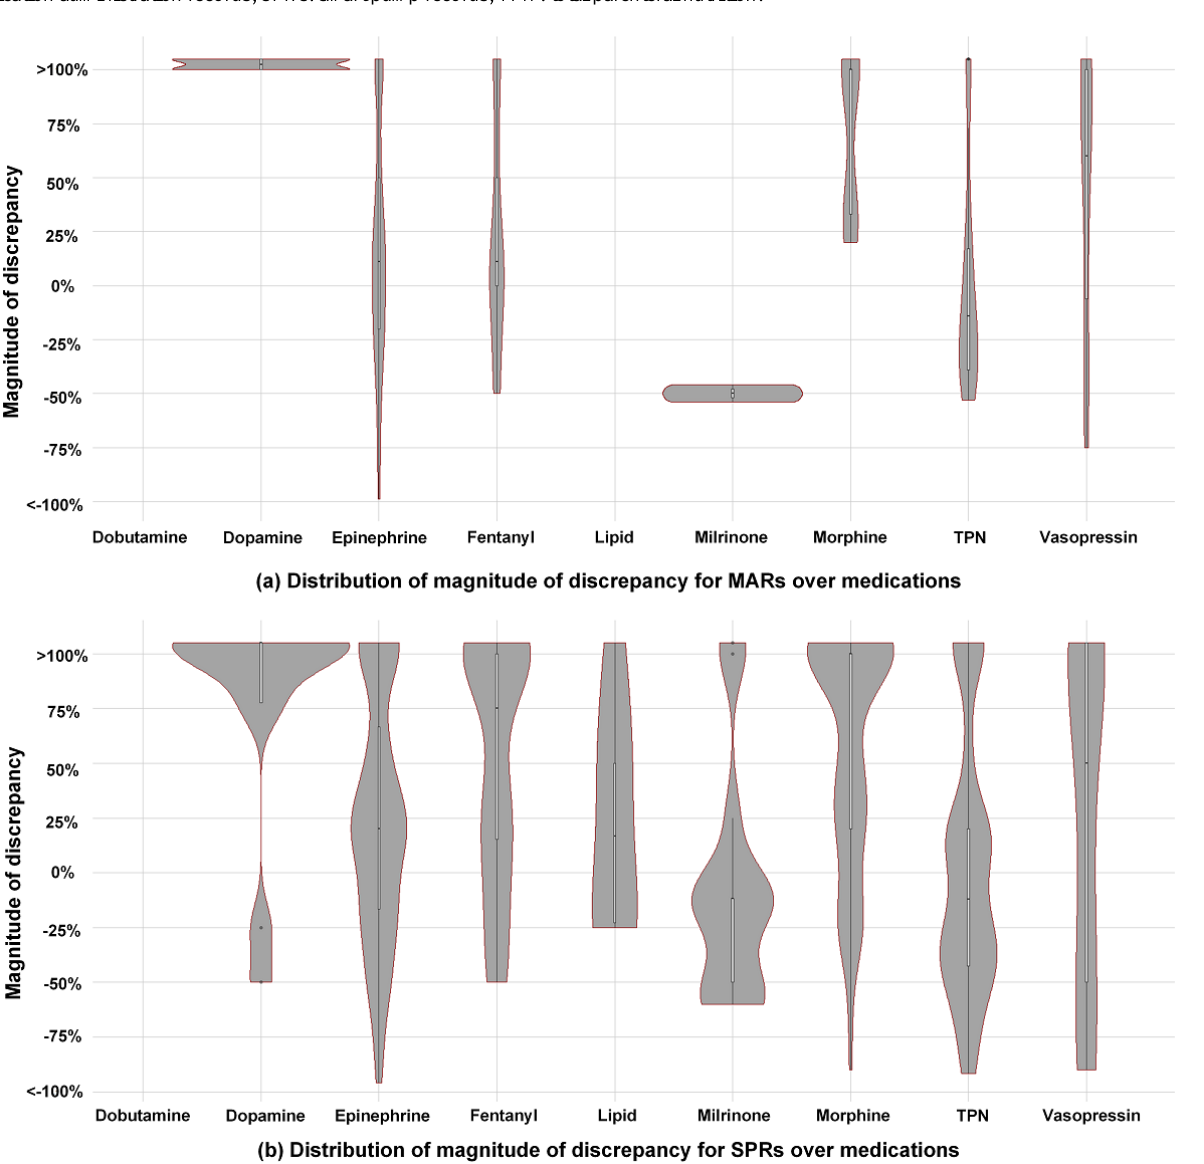
Figure 3. Distribution of magnitude of discrepancy for (a) medication administration records and (b) smart pump records over medications.